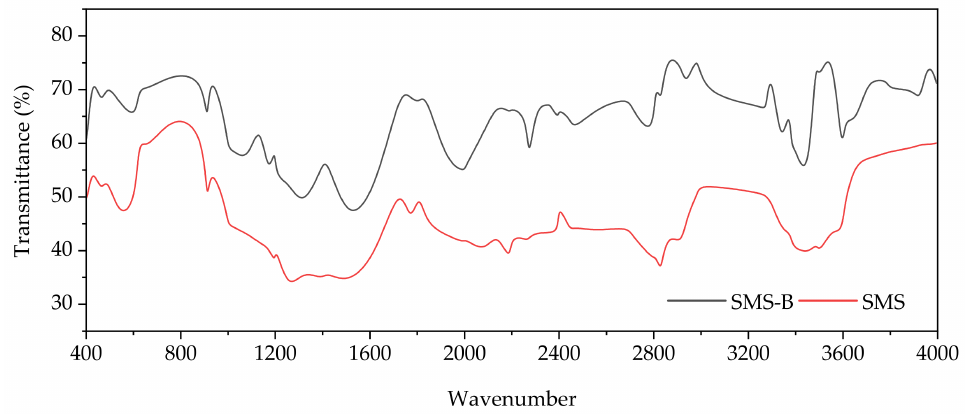
Figure 3. FTIR spectra of the spent mushroom substrate (SMS)-based and its biochar (B) derived through pyrolysis (unit of wavenumber: 1/cm).